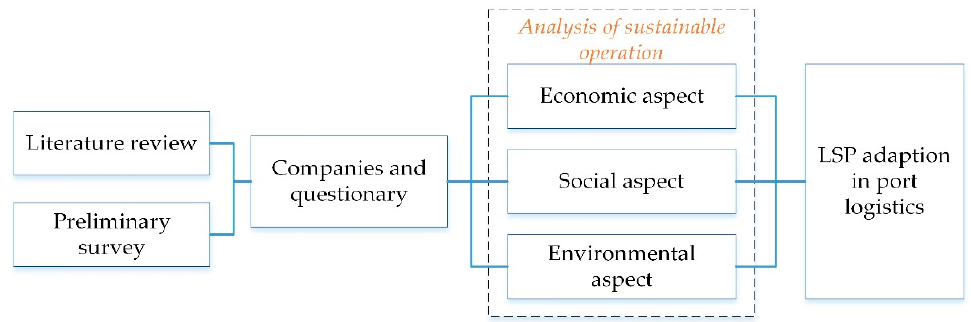
Figure 1. Three-step research methodology.